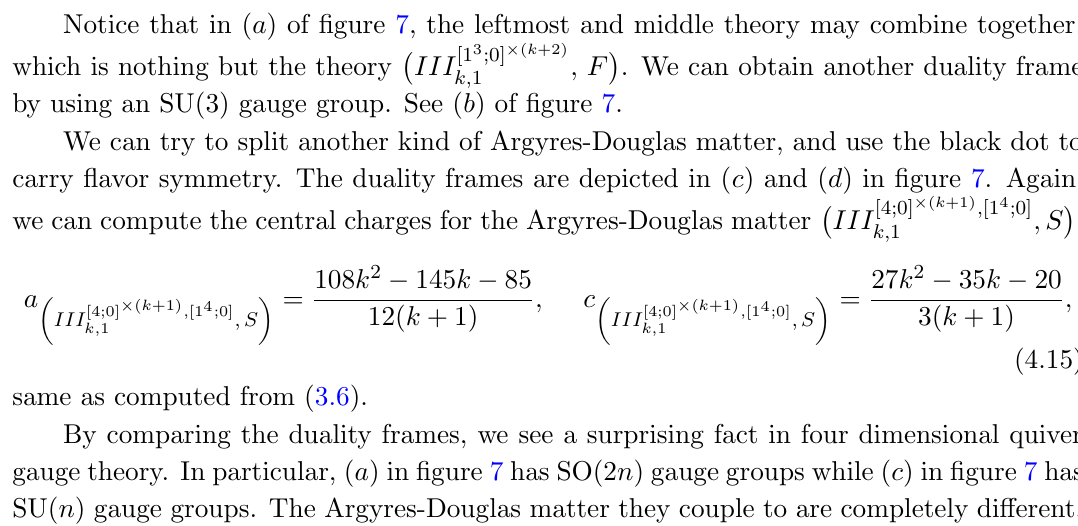
(cid:2) ( k +1) ; [1 ; 1 ; 1 ; 1] (cid:0) (cid:1) III [3 ; 1] ; F . The lower k; 1 (cid:2) ( k +1) ; [1 ; 1 ; 1;0] (cid:0) (cid:1) III [3;0] ; F . All the computation can k; 1